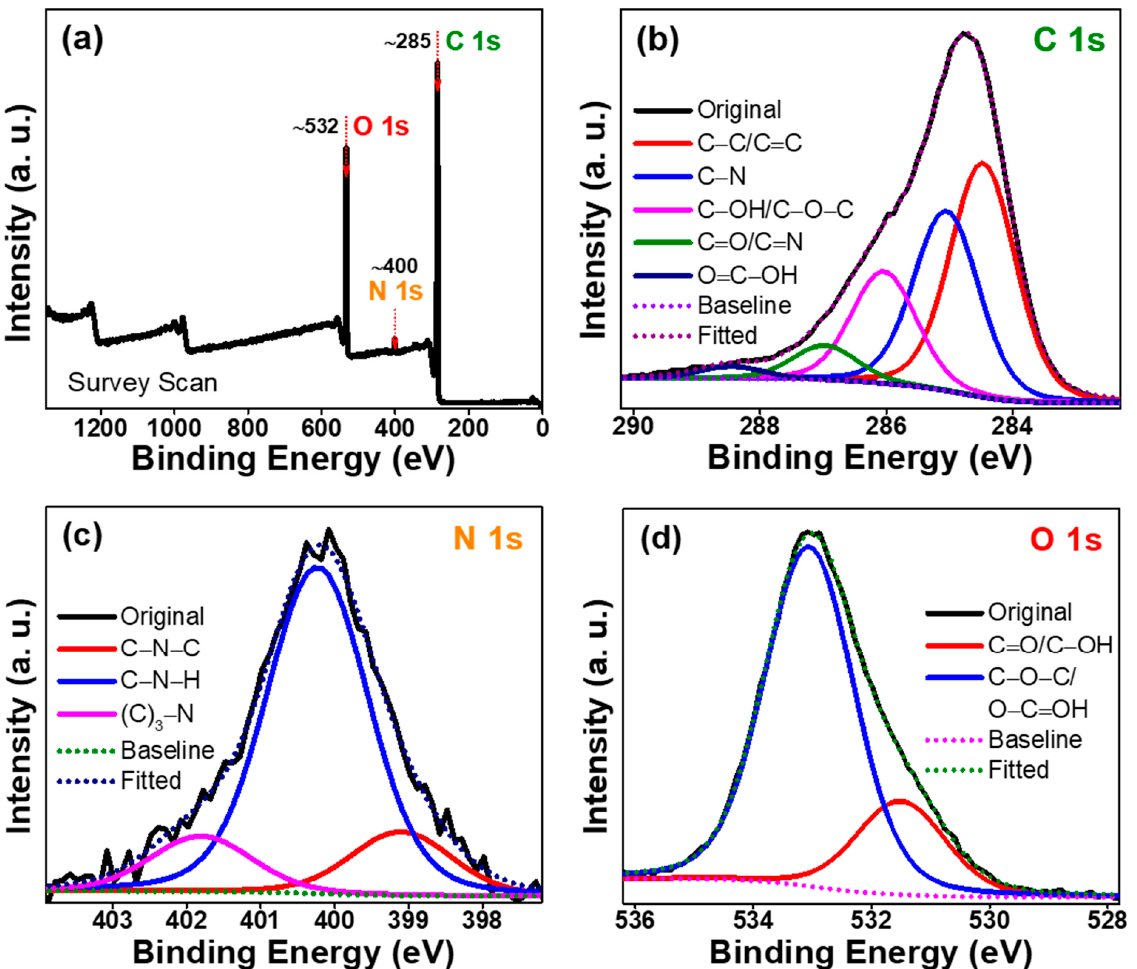
Figure 4. ( a ) XPS-survey spectrum and high-resolution XPS spectra of ( b ) C 1 s, ( c ) N 1 s, and ( d ) O 1 s of synthesized F-CNDs. 1 s of synthesized